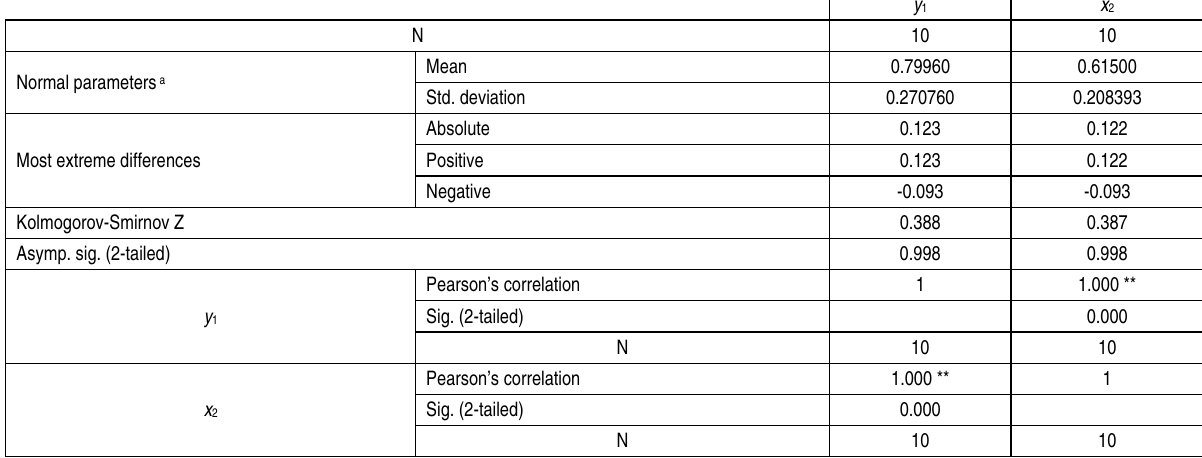
Table 14. The second hypothesis test result (normality test and correlation analysis) Normal parameters